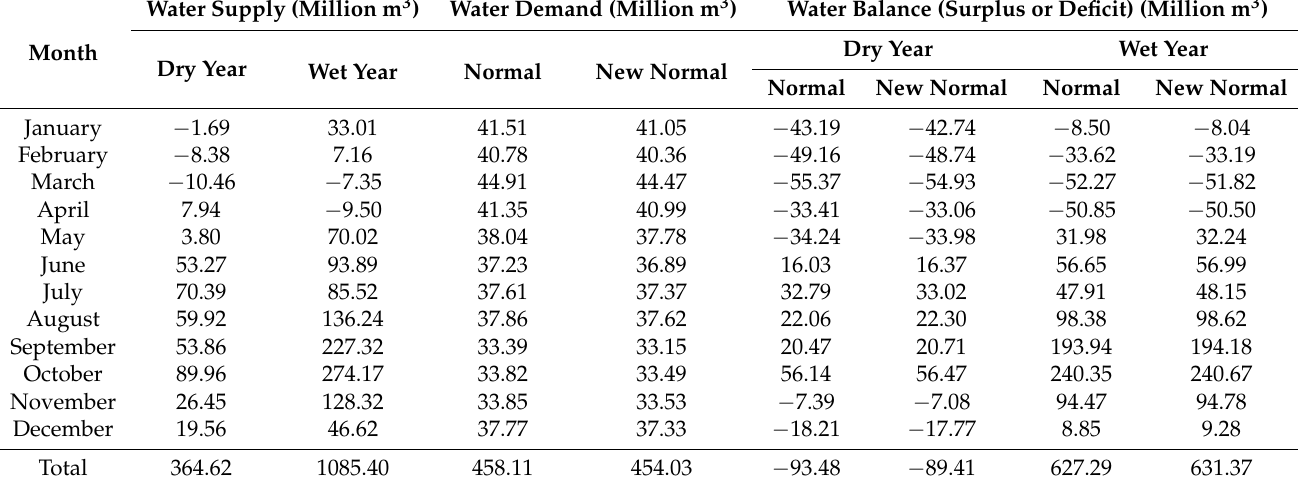
Table 27. Monthly water supply and demand balance evaluation with the consideration of ecological water requirements between 2020 and